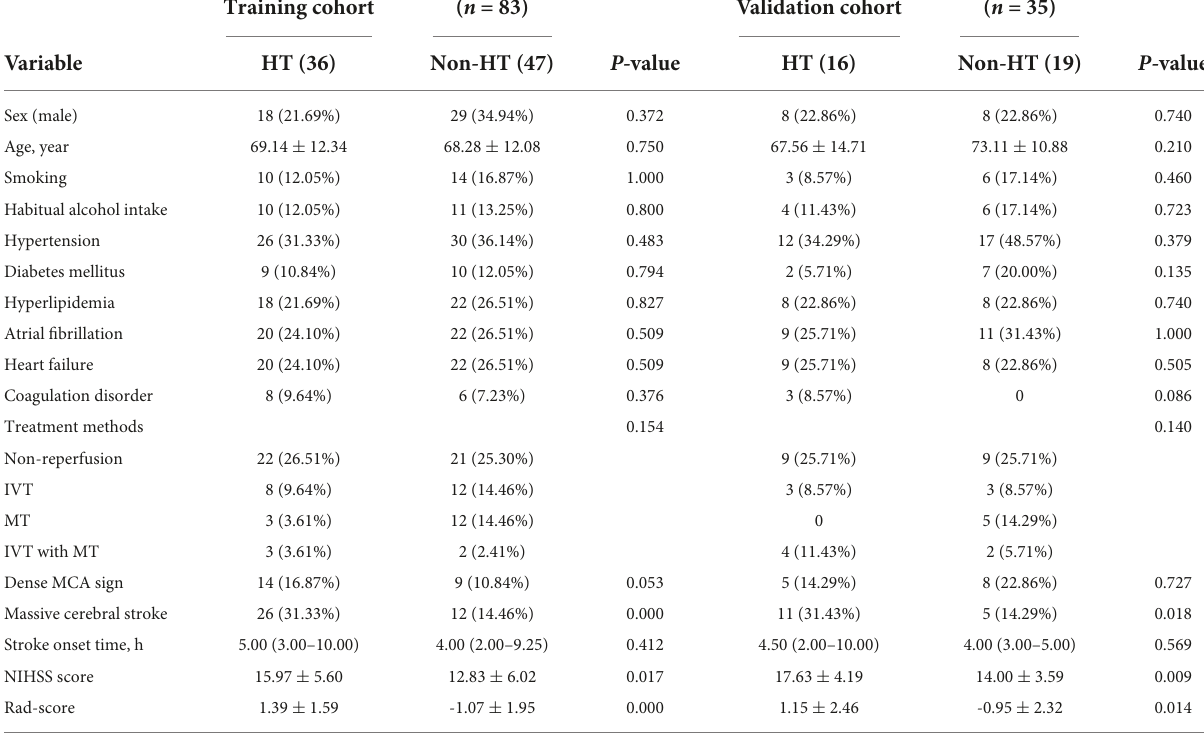
TABLE 1 Baseline characteristics of the hemorrhagic transformation (HT) and non-HT groups in the training and validation cohorts. Training cohort